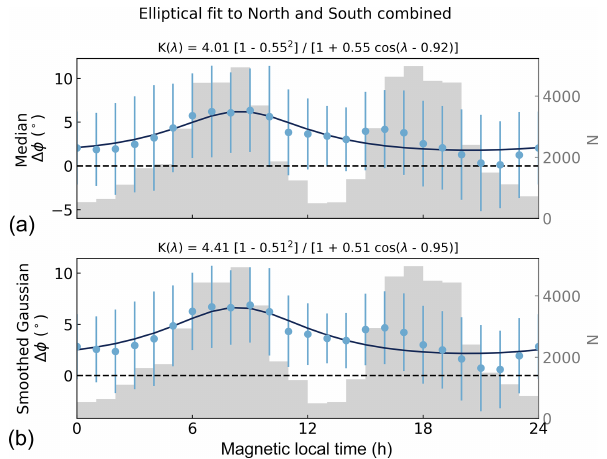
Figure 3. Elliptical boundary correction (black line) fit to the me- dian (a) and S.G. peak (b) (cid:49)φ for both hemispheres. The blue dots and scatter bars show the central value and (cid:15) in each MLT bin re- spectively. The grey histogram shows N MLT , and scales to the y axis on the right.